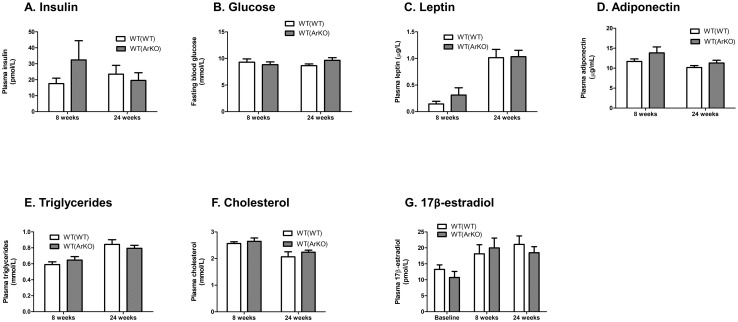
Plasma analytes in wild-type (WT) male mice transplanted with bone marrow from either WT (WT(WT)) or aromatase-deficient (WT(ArKO)) donors.At both study week 8 and study week 24, no differences were found between groups in fasting plasma concentrations of insulin (A), glucose (B), leptin (C), or adiponectin (D). Fasting plasma cholesterol (E) and triglyceride (F) concentrations were similar between groups at both timepoints, and plasma concentrations of 17β-estradiol remained comparable between groups throughout the study (G).